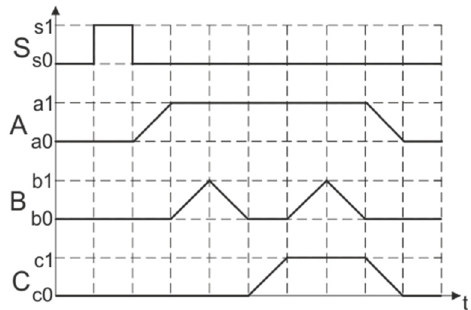
Figure 2. System operating cycle diagram.